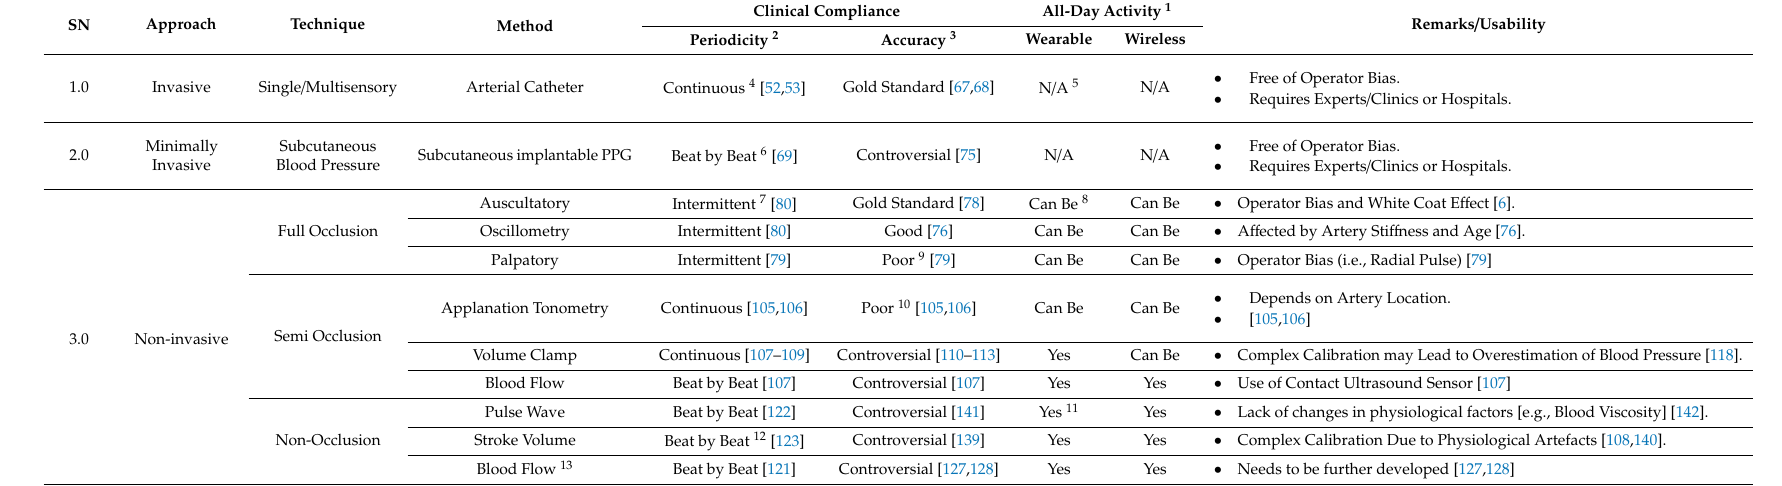
Table 1. Summary of current blood pressure measurement techniques and assessment of their potential for accurate yet continuous wearable blood pressure measurement